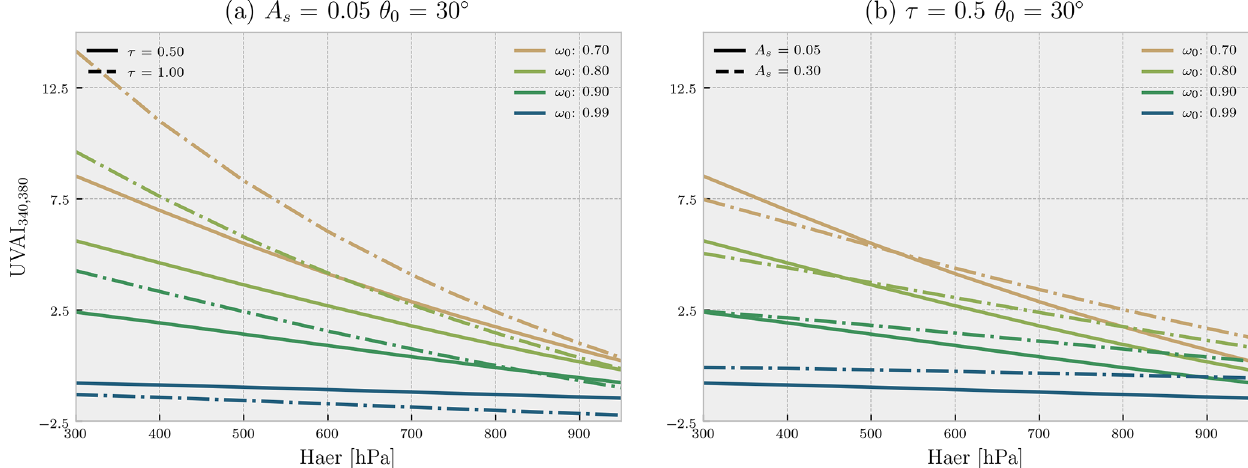
Figure A2. Sensitivity analysis of UV aerosol index to show the influence of different aerosol properties on the UVAI. The aerosols in these analyses have a Henyey–Greenstein scattering phase function with an asymmetry factor of 0.7; an Ångström exponent of 1.0; viewing zenith angle of 0 ◦ ; and the solar azimuth angle and the viewing azimuth angle of 0 and 60 ◦ , respectively; the surface pressure is 1013hPa and, for this specific case, the solar zenith angle θ 0 is 30 ◦ . The y axis is the UVAI for 340 and 380nm, whereas the x axis is the height of the geometric centroid of the aerosol layer (in hPa, Haer). The legends in each of the plots describe the different configurations chosen for these sensitivity analyses. Panel (a) looks into the sensitivity of UVAI with a fixed surface albedo of 0.05, and panel (b) does the same for a fixed AOT of